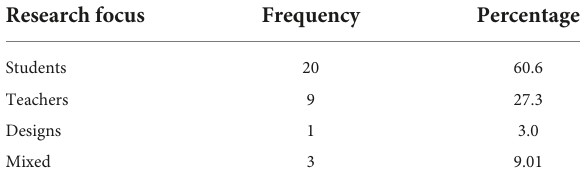
TABLE 2 Distribution of research papers on the of virtual and augmented reality in science and math education in Arab countries by research focus ( n =